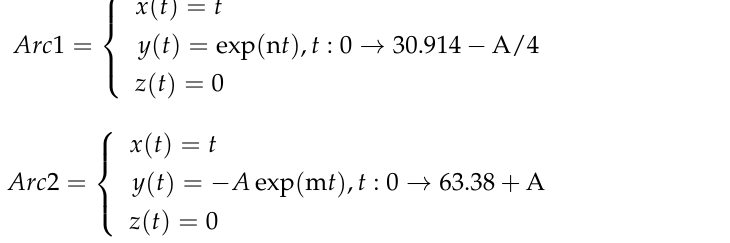
Table 1. Mechanical parameters of the basic Vivaldi antenna (all parameters are presented in mm).